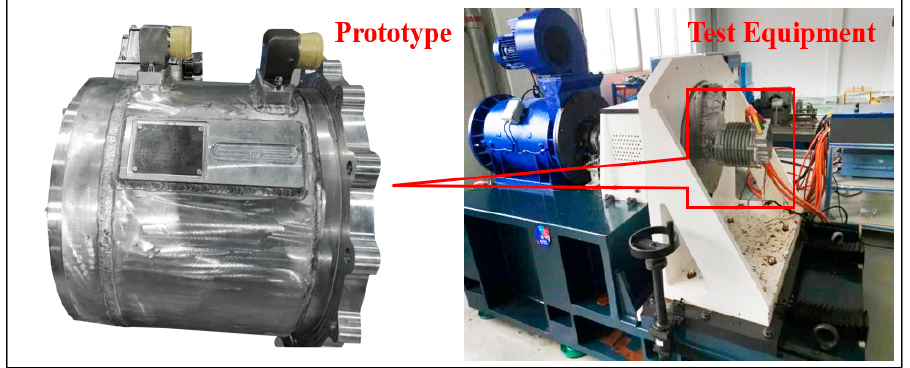
Figure 9. Prototype and test